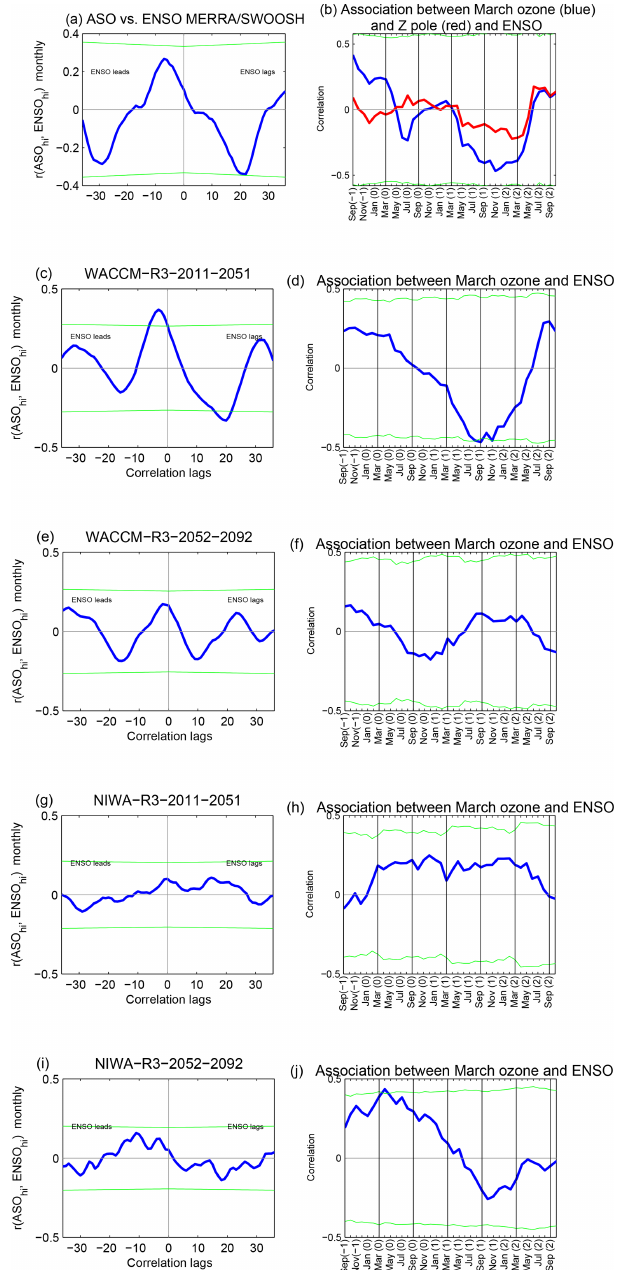
Figure 8. Lagged correlation between ASO and ENSO for (a– b) MERRA/SWOOSH, (c–f) WACCM-R3, and (g–j) NIWA-R3. The left column shows the lagged correlation for all calendar months, and the right column shows the association between March ASO of every year and ENSO of every month across all years af- ter regressing out ODS and greenhouse gas changes as described in Sect. 2. The green lines mark the Student t test 95% confidence level – correlations that exceed the upper green line or are more neg- ative than the lower green line are statistically significant. The red line in subplot (b) represents the correlation between March polar geopotential height and